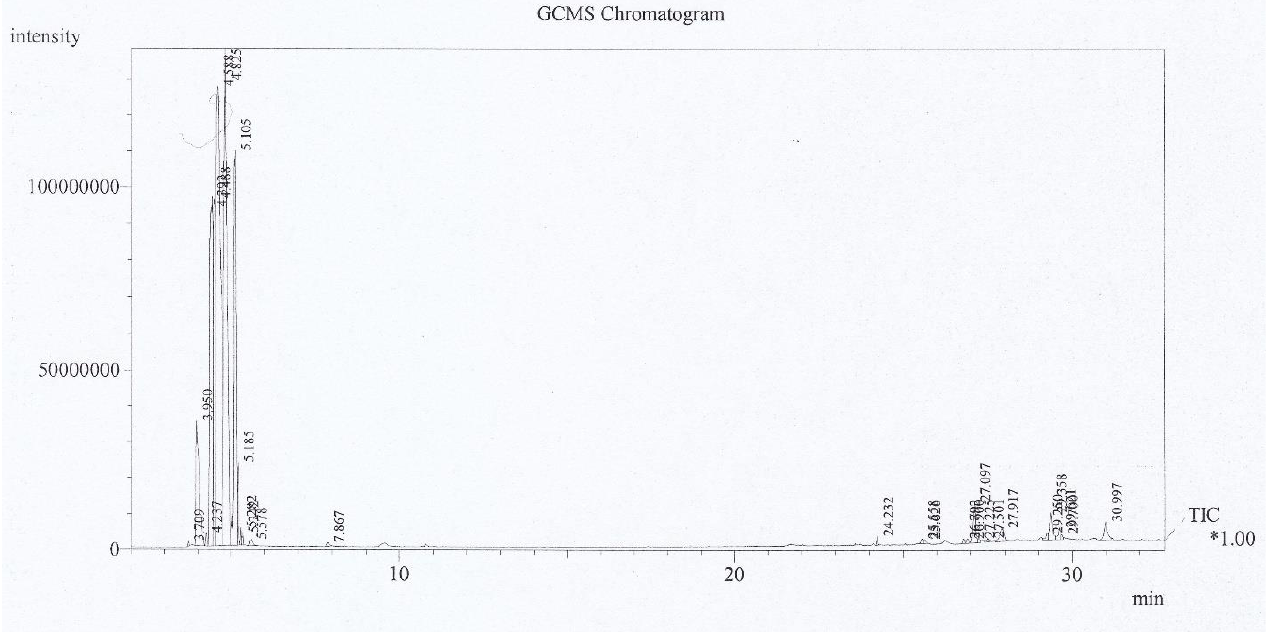
Figure 1. GC-MS chromatogram of P. australis extract. The y-axis represented the intensity count, while the x-axis represented the amount of time in minutes. Tentatively Identified Compounds (TIC) are computed using total ion areas for the TIC and the internal standard, and a relative response factor of *1.00 is assumed. Table 3. GC-MS analysis of P. australis extract.